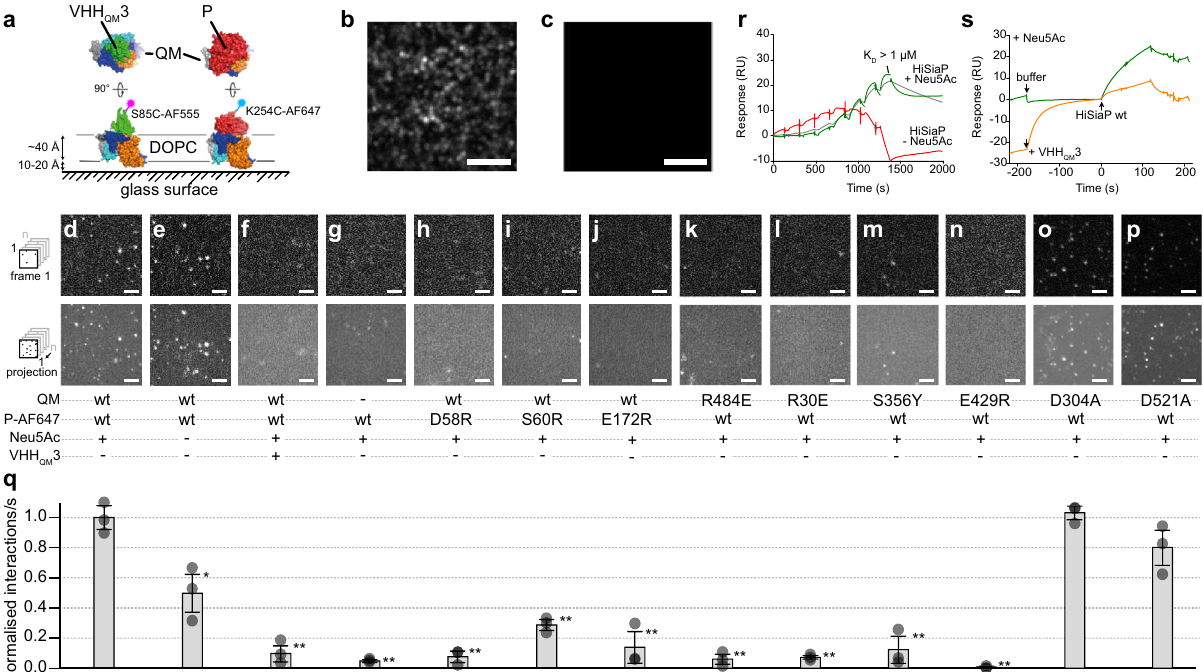
Fig. 6 Single-molecule interaction studies of HiSiaQM and HiSiaP on solid-supported bilayers (SSBs). a HiSiaQM variants were integrated into DOPC (1,2-Dioleoyl-sn-glycero-3-phosphocholine) SSBs and their interaction with single AF-647-labelled P-domain variants or AF-555-labelled VHH QM 3 was observed by TIRF microscopy. b SSB containing HiSiaQM visualised with AF-555 labelled VHH QM 3. c As a control, VHH QM 3-AF-555 was added to an SSB in the absence of HiSiaQM. No unspeci fi c binding was observed. d – p Top row: fi rst frame of an image sequence of a typical set of data. Bottom row: maximum intensity projections of the respective image sequence. The conditions are indicated below each panel. q Normalised interactions per second of P-domain variants with a SSB containing HiSiaQM variants. Unless otherwise stated, the P-domains were pre-incubated with 10 mM sialic acid (Neu5Ac). Statistical signi fi cance of the P-mutants and controls was assessed by applying a two-sided unpaired Student ’ s t -test with a 95% con fi dence interval (* p < 0.01, ** p < 0.001). The full dots represent the average results of n = 3 independently prepared samples, respectively. The bars represent the mean value of the three averages. The distribution of the full dots indicates for every condition the reproducibility of the results. For each of these three samples, a fresh bilayer was prepared on a new coverslip and n = 30 individual measurements were performed. The underlying data is compiled in Supplementary Table 3. The scale bars equal 3 μ m. r Sensorgrams showing the interaction of the P-domain with immobilised QM-domains (HiSiaQM K273C-biotin in DDM) in the absence (red) or presence (green) of sialic acid (5 mM). The green curve was fi t with a 1:1 binding model (grey). Four independent experiments were performed. s Competition experiment between the P-domain and VHH QM 3 for the immobilized QM-domains. Green curve: a buffer injection followed by an injection of the P-domain. Orange curve: the chip surface was saturated with VHH QM 3 before the P-domain was added. Single experiment, supported by multiple other experiments in this study (e.g. panel ( f ), Fig. 3b, the cryo-EM structure). Source data are provided as a Source Data fi